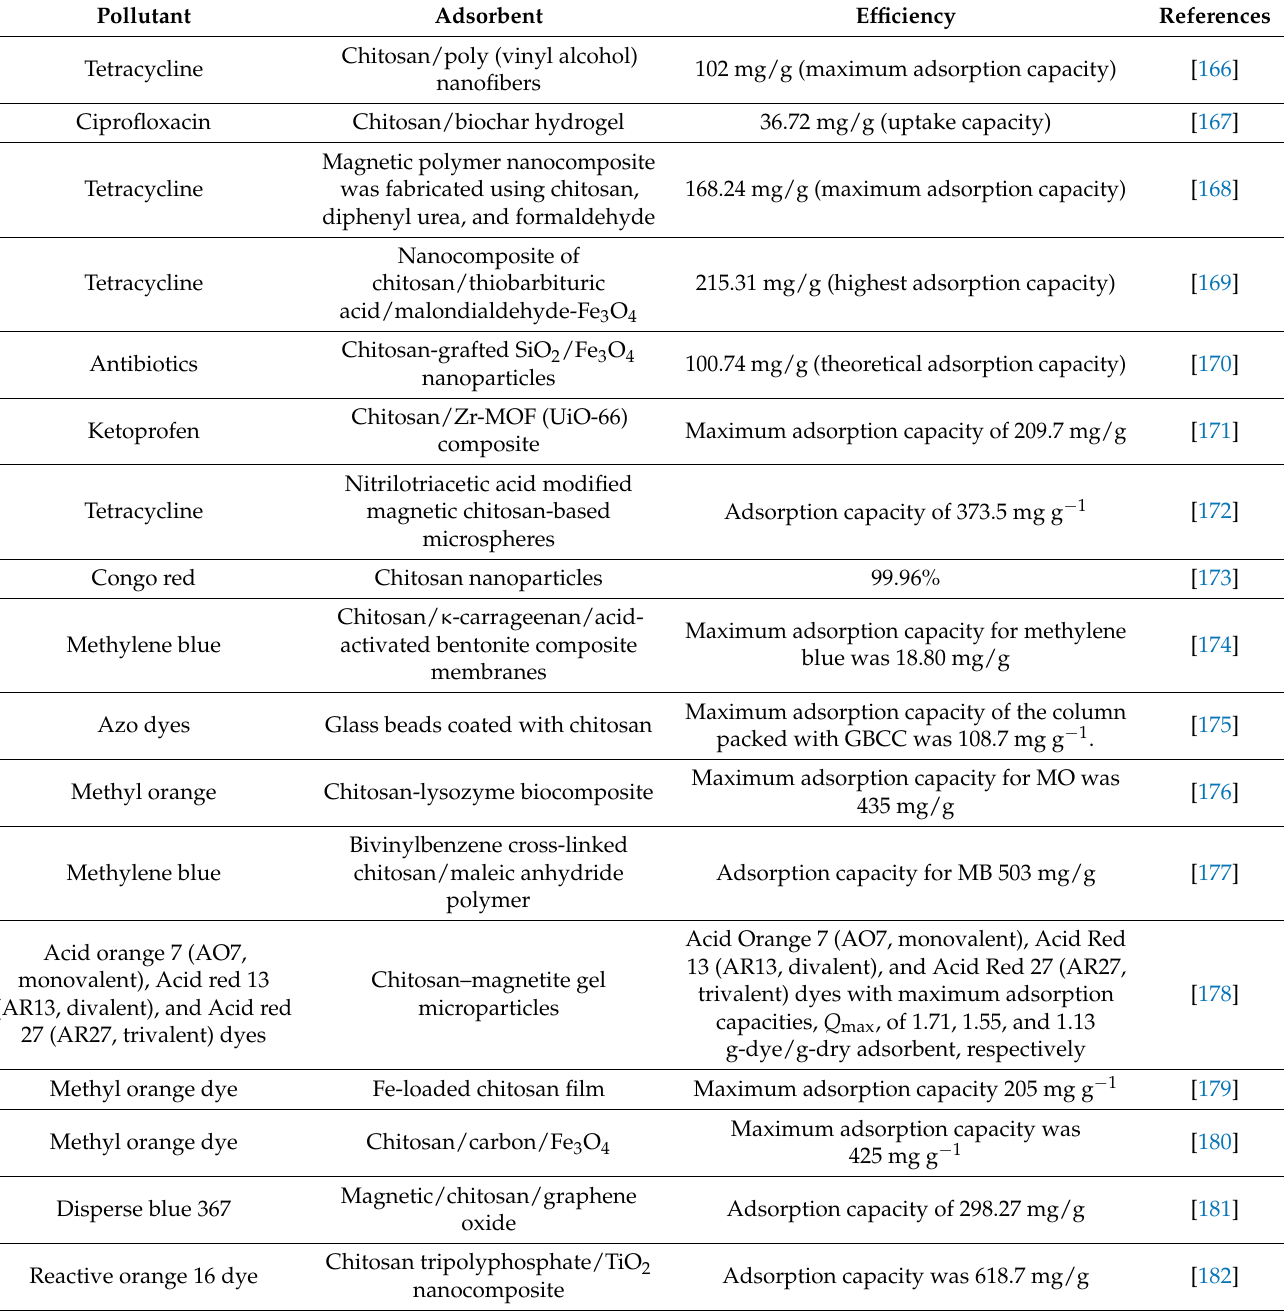
Table 7. Examples of pollutants removed by chitosan and